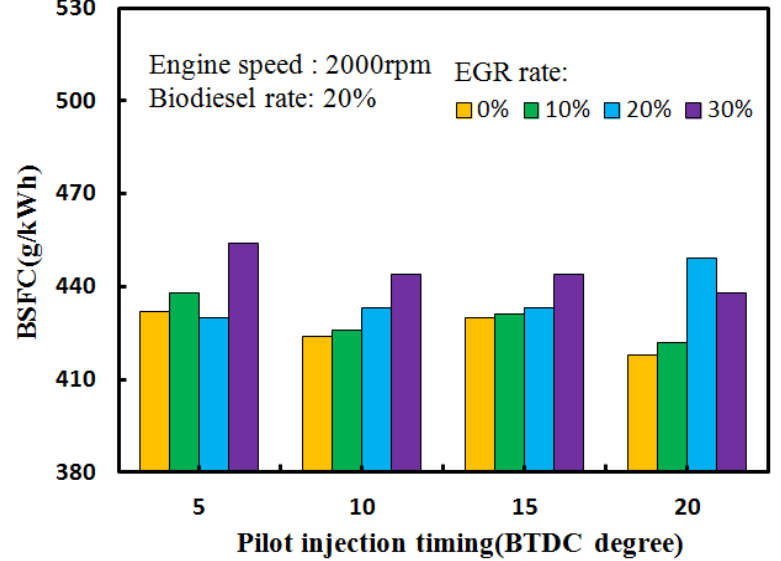
Figure 6. Effects of EGR ratio and pilot injection timing on the